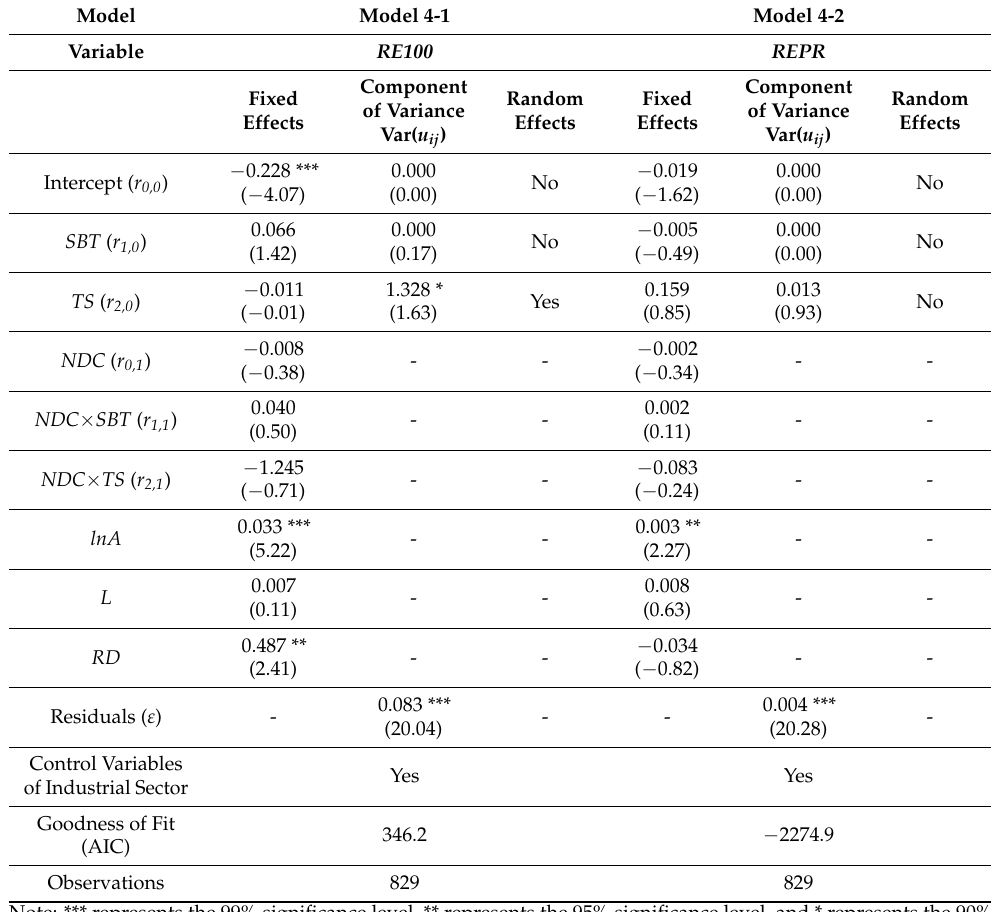
Table 6. The results of random slope regression model estimates under the